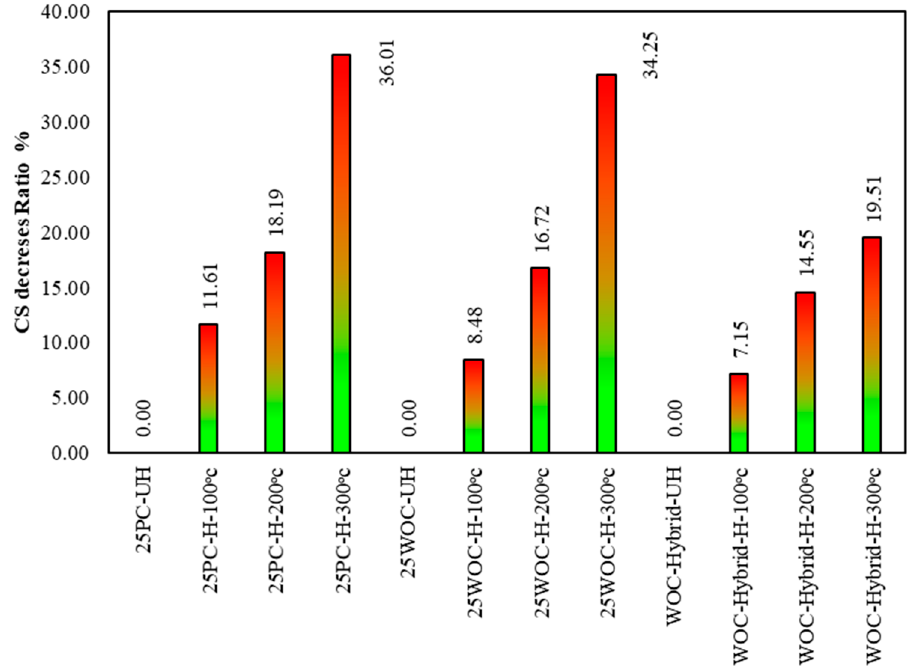
Figure 8. The percentage decrement in compressive strength of PC, WOC, and hybrid specimens at elevated temperatures to samples strength at 25 °C.